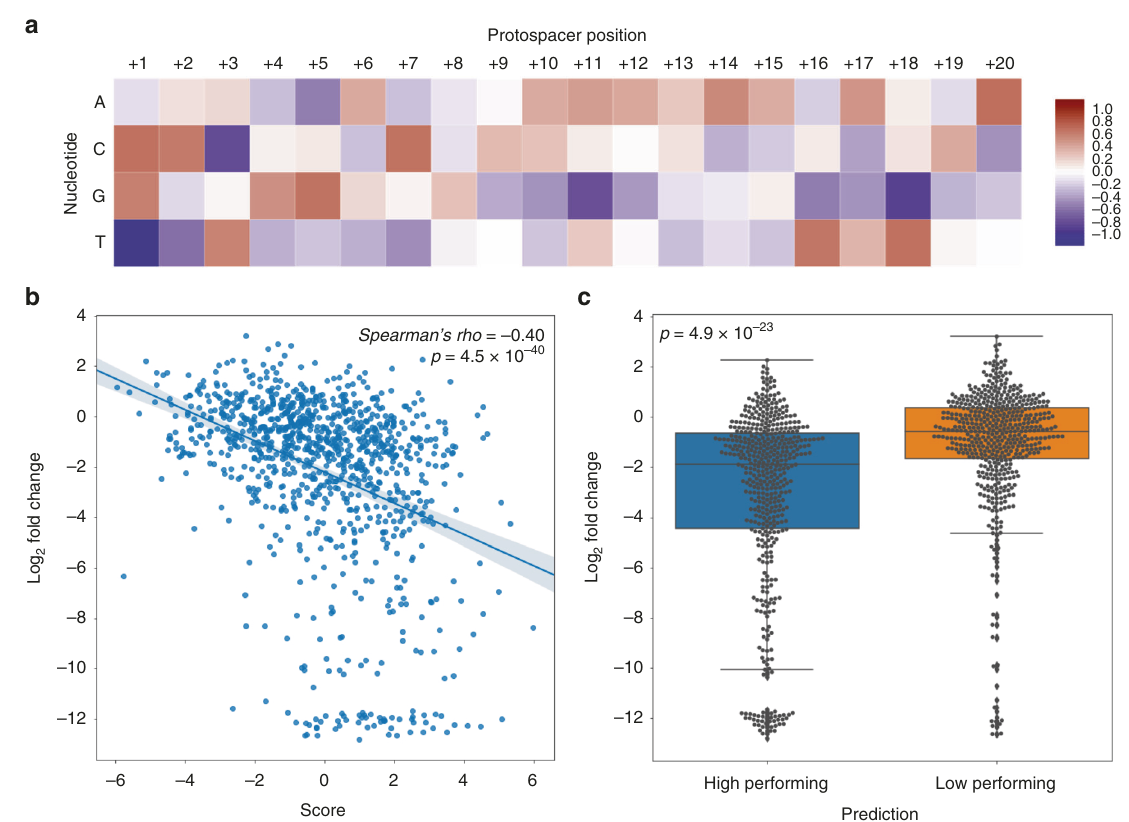
Fig. 2 Sequence preference features of AsCpf1 a The scoring matrix for the prediction of AsCpf1 activity on endogenous loci. A positive value (in red tone) indicates a preference towards a nucleotide for a high-performing guide while negative value (in blue tone) indicates a preference against a high- performing guide. The position of the fi rst nucleotide adjacent to PAM is de fi ned as position + 1 for the protospacer. b Correlation between AsCpf1 guide prediction scores and depletion levels of core-essential genes in the AsCpf1-based mono-cistronic library screenings. The predicted AsCpf1 guide scores for each guide in the validation set across 100 bootstrappings were plotted against their log2 transformed fold change in the screen ( n = 342). Line of best fi t is plotted and the shaded area is presented as s.d. c Box plot of predicted high-performing AsCpf1 guides (HighPerforming) and low-performing guides (LowPerforming) across 100 bootstrappings. Guides were de fi ned as high-performing if predicting score >0 and low-performing if predicting score ≤ 0 ( n = 342). Centerlines are present as medians. Bounds of boxes are present as fi rst and third quantiles and whiskers are present as minimums and maximums without outliers. Source data are provided as a Source Data fi